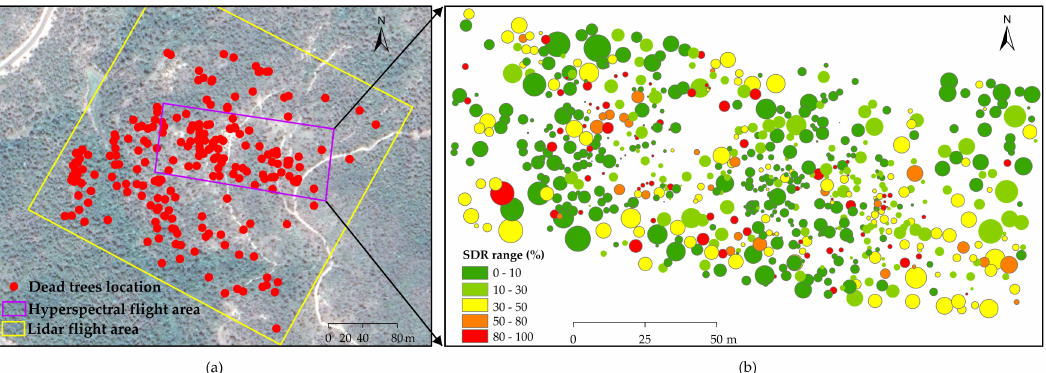
Figure 10. ( a ) Dead trees and their locations mapping using the lidar approach in the lidar flight area; ( b ) tree crown SDR mapping using the combined approach in the hyperspectral flight